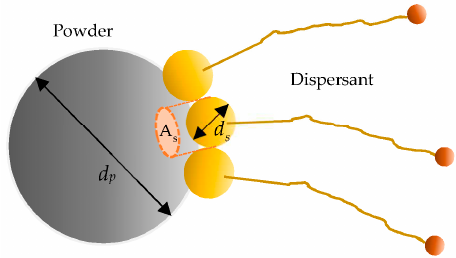
Figure 3. Idealized coverage model of the dispersant on spherical powder [25].